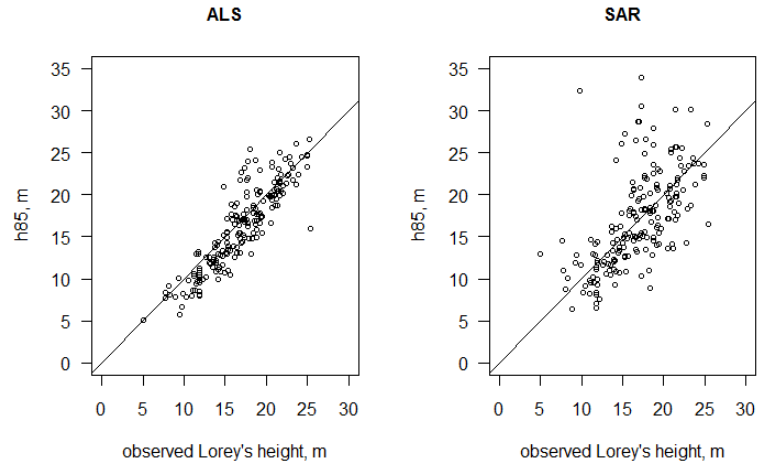
Figure 3. The 85th percentile (h85) of the ALS and SAR points related to observed Lorey’s height at the plot